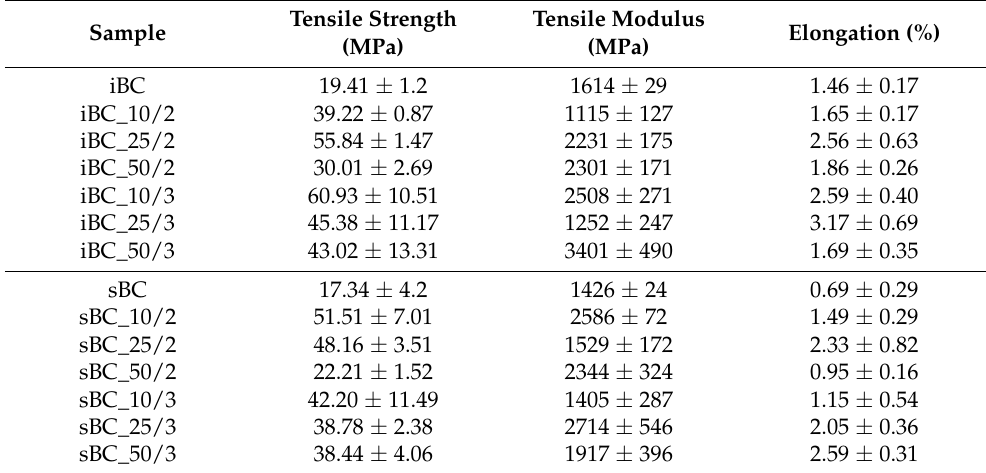
Table 4. Mechanical properties of BC and GO/BC